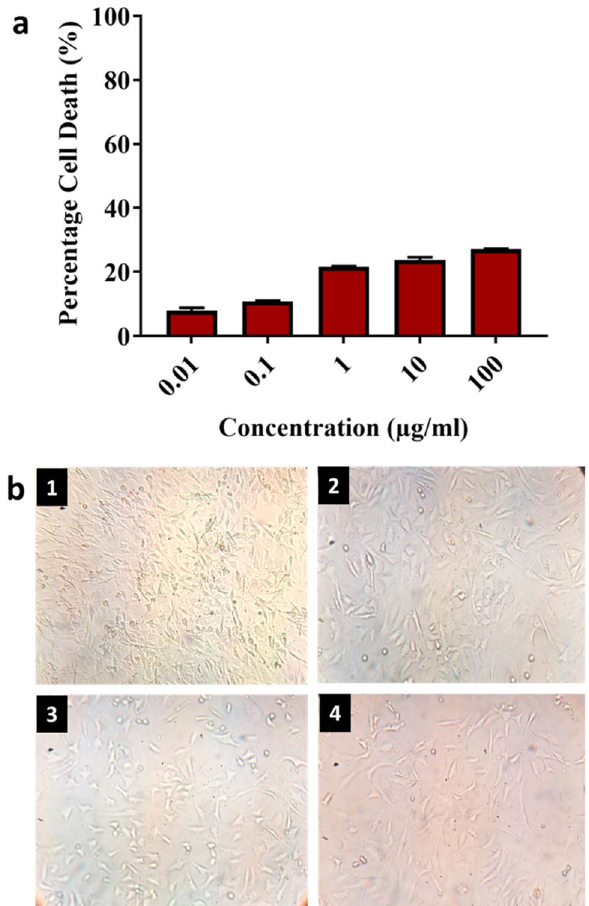
3T3 cell lines treated by 1 µg/ml AgNPs b4. 3T3 cell lines treated by 100 µg/ml